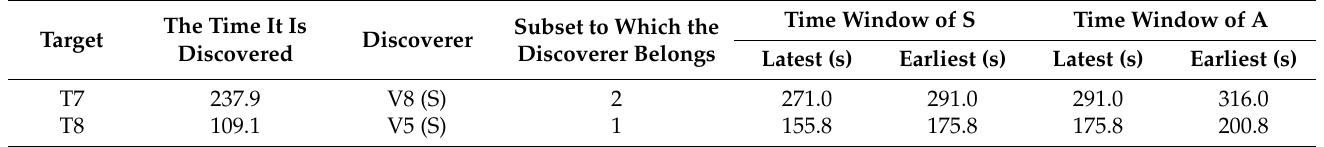
Table 7. Information of unknown targets and corresponding